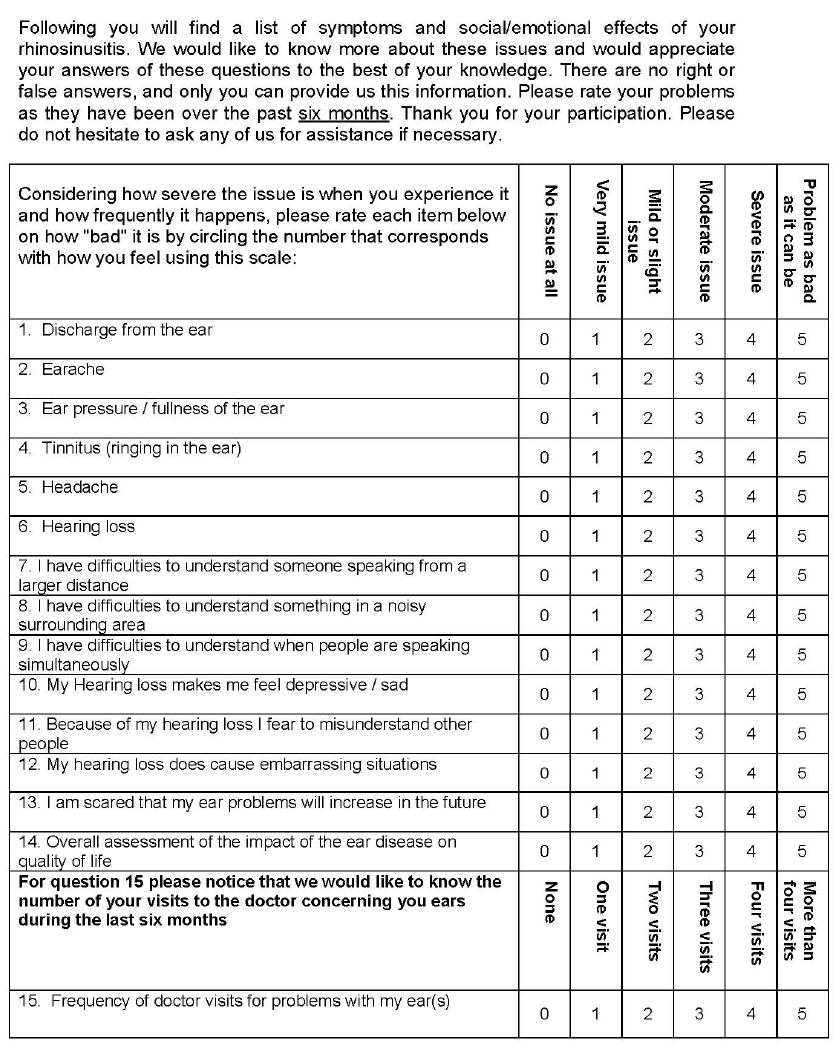
Figure 1. The Italian and English versions of the